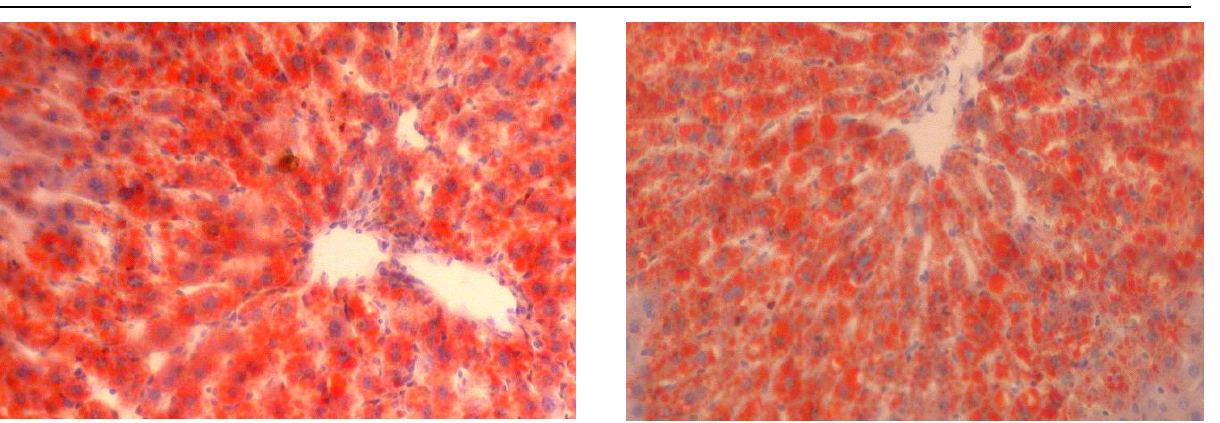
Fig. 8. Rat liver, which on the background of ethyl alco- Fig. 10. Rat liver, which on the background of alcohol hol was injected WSPC of plum fruit. Small drops of fat was injected silibor. The diffuse nature of the distribution of fat droplets. Frozen tissue slices, Sudan ΙV. ×200 in hepatocytes were diffuse in the lobe. Frozen tissue slices, Sudan ΙV. x200 Simultaneous administration of alcohol and fiber of fruit plums in a dose of 200 mg / kg prevents the de- velopment of fatty dystrophy of the liver parenchyma, in contrast to the similar scheme of the introduction of a WSPC of plum fruit in the same dose or drug comparison of silibor at a dose of 30